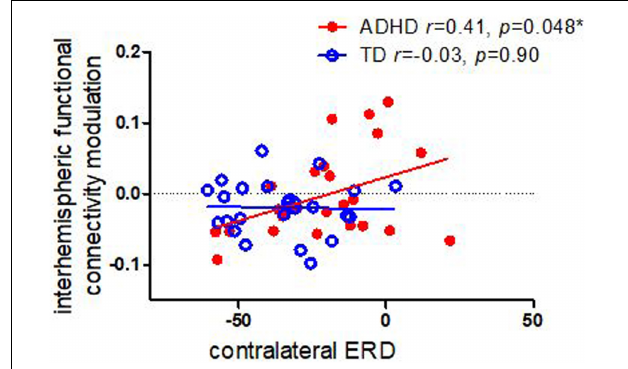
FIGURE 2 | Correlations between task-related interhemispheric functional connectivity modulation in alpha and contralateral ERD in children with ADHD TD controls. Children with ADHD showed a significant association between functional connectivity modulation and ERD, whereas controls did not.